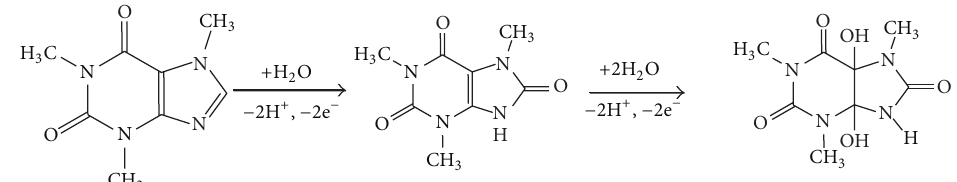
Scheme 1: Mechanism for the electrochemical oxidation of caffeine.